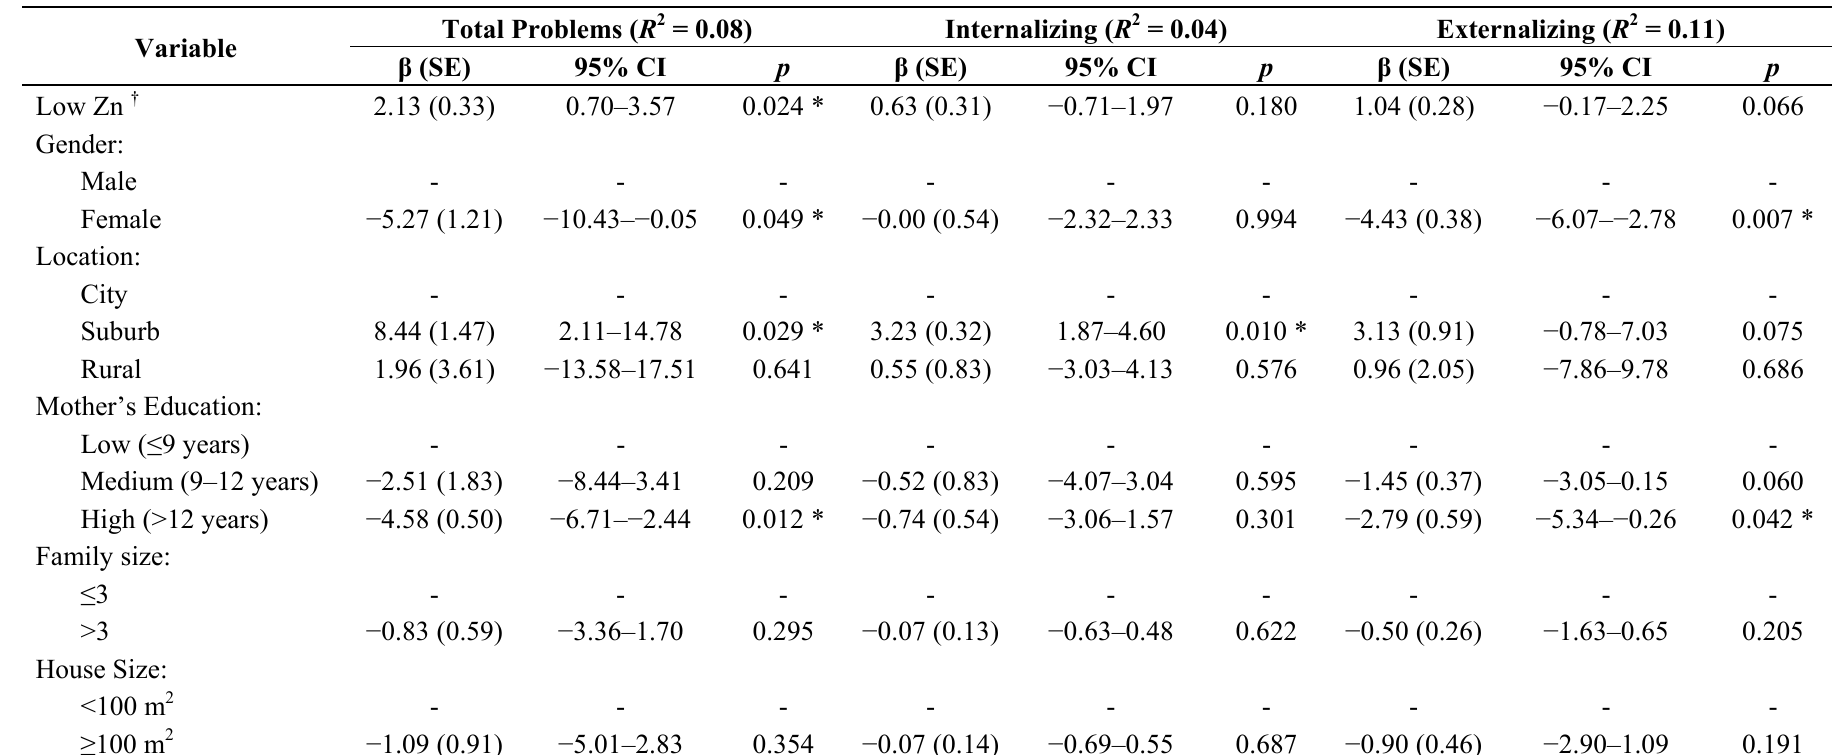
Table 5. The effect of Zinc on children’s behavior problems ( N =